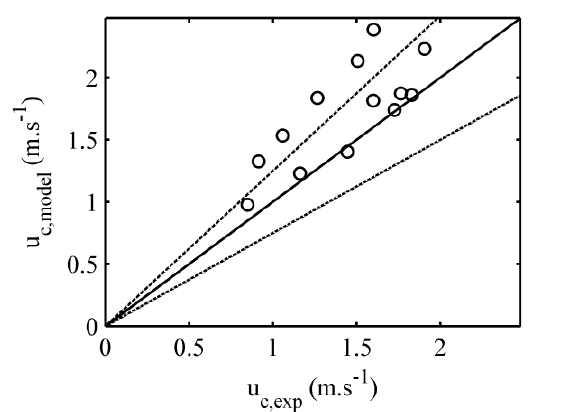
Fig. 13. Parity plot for experimental and predicted velocity at top of transport layer of FA60 flow. Legend: lines of perfect fit and of ± 25 per cent